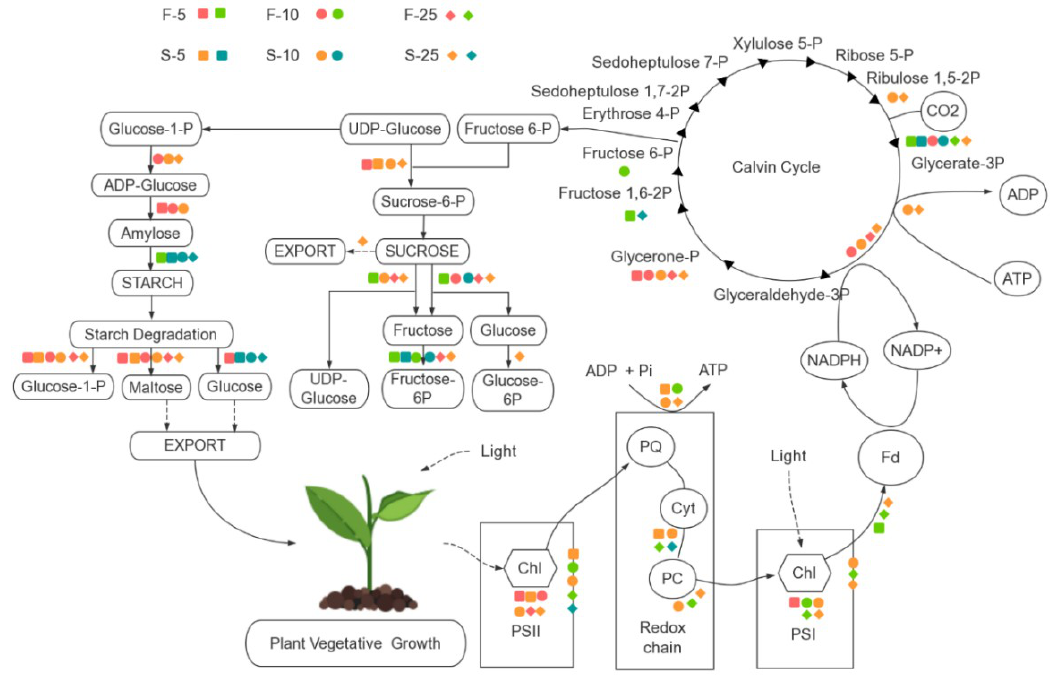
Figure 6. DEGs involved in metabolism pathway in the leaves of triploid-F and triploid-S plants. Warm and cool colors represent upregulated and downregulated expression,